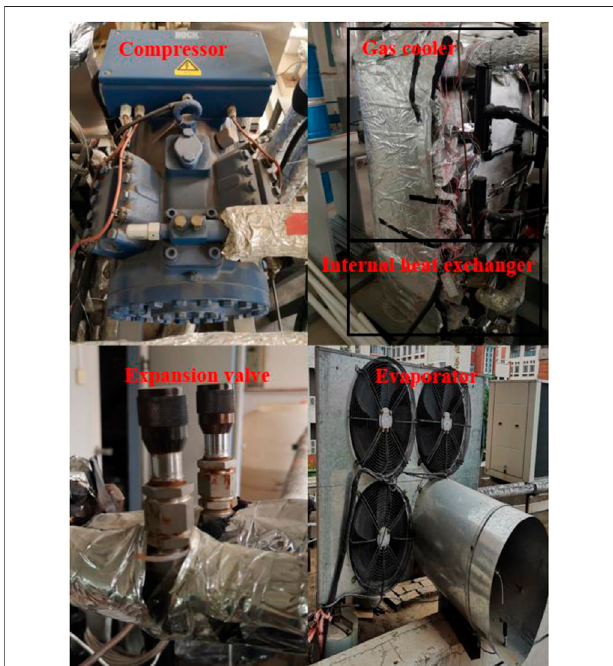
FIGURE 2 | Experimental facilities.